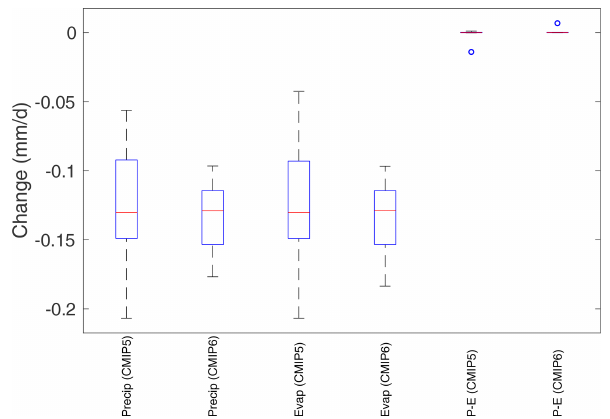
Figure 10. Global mean ensemble median (red lines), interquar- tile (blue boxes), and ranges (black whiskers or, for P – E , one blue circle indicating an extreme outlier) for the hydrological quantities shown in Fig. 9 for both the CMIP5 and CMIP6